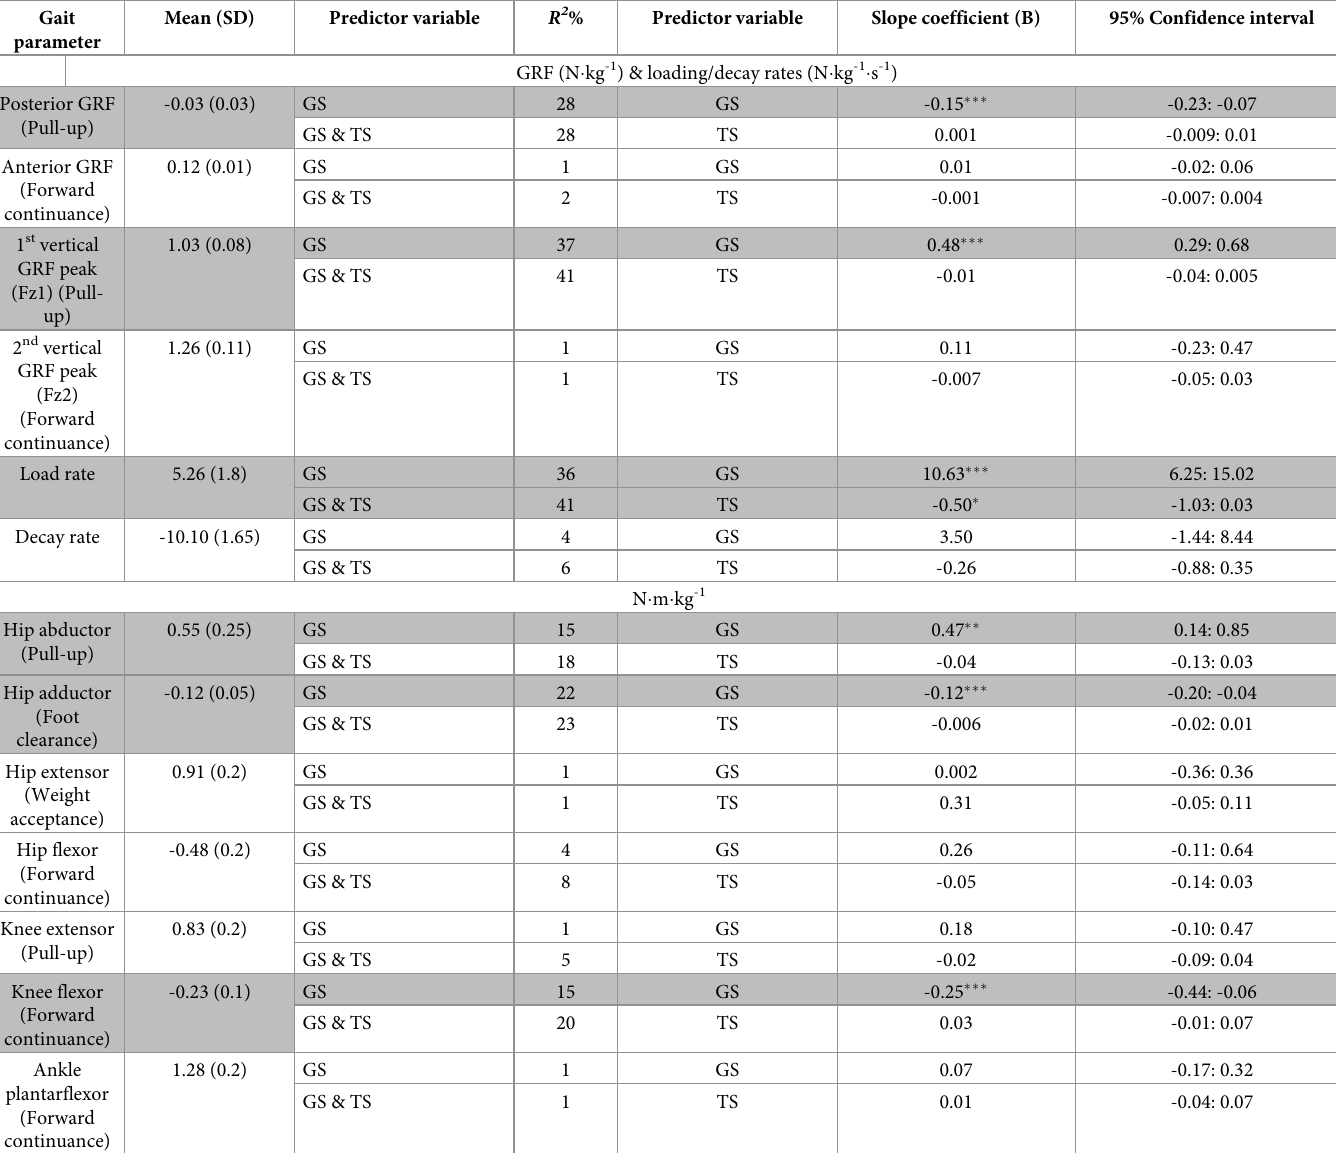
Table 3. Explained variance ( R 2 ) and slope coefficient for peak ground reaction forces and peak joint moment during stair ascent. Gait